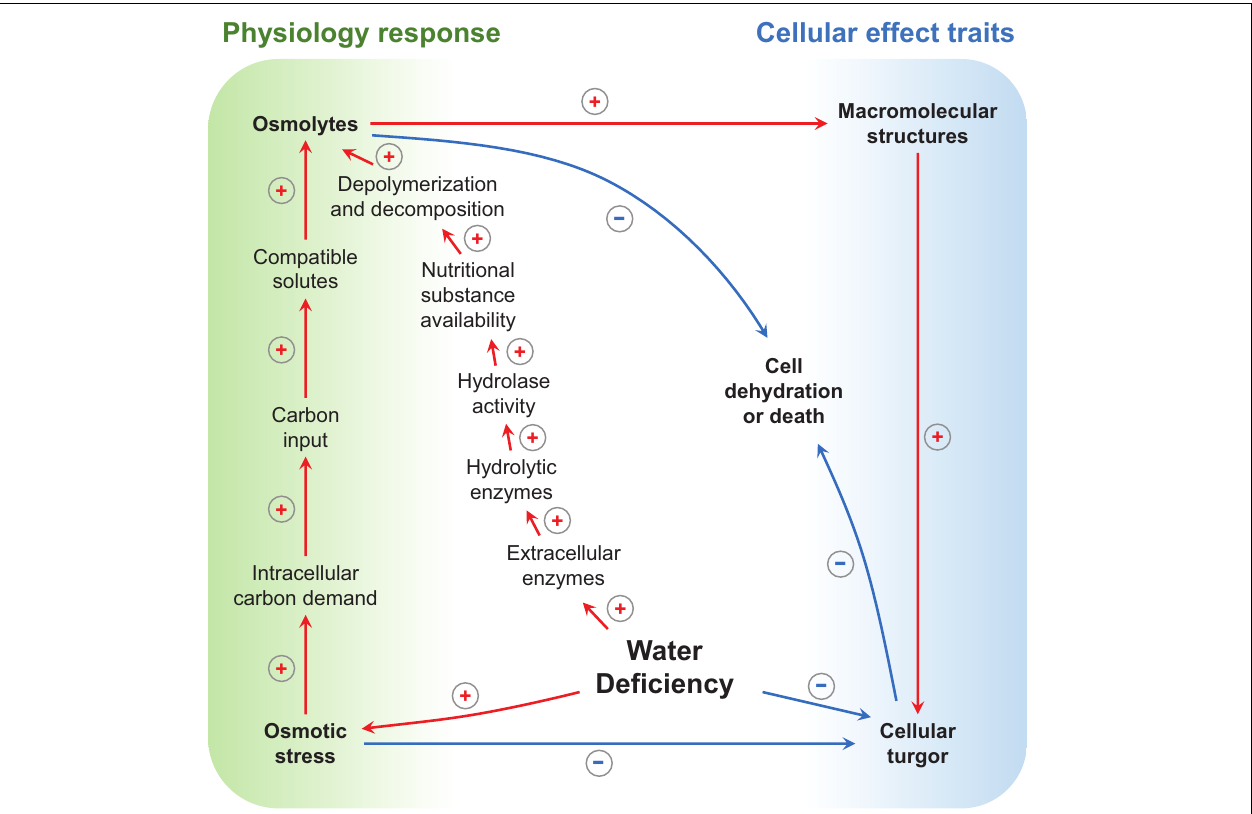
FIGURE 5 | Microbial physiology response and cellular effect traits under water deficiency. Arrows indicate influence processes, positive red signs represent increase or enhancement, and negative blue signs represent reduction (drawn by the authors).